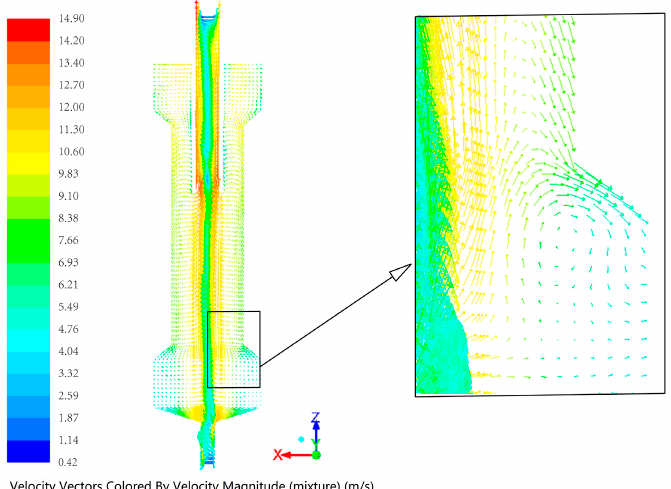
Figure 17. Velocity vector.